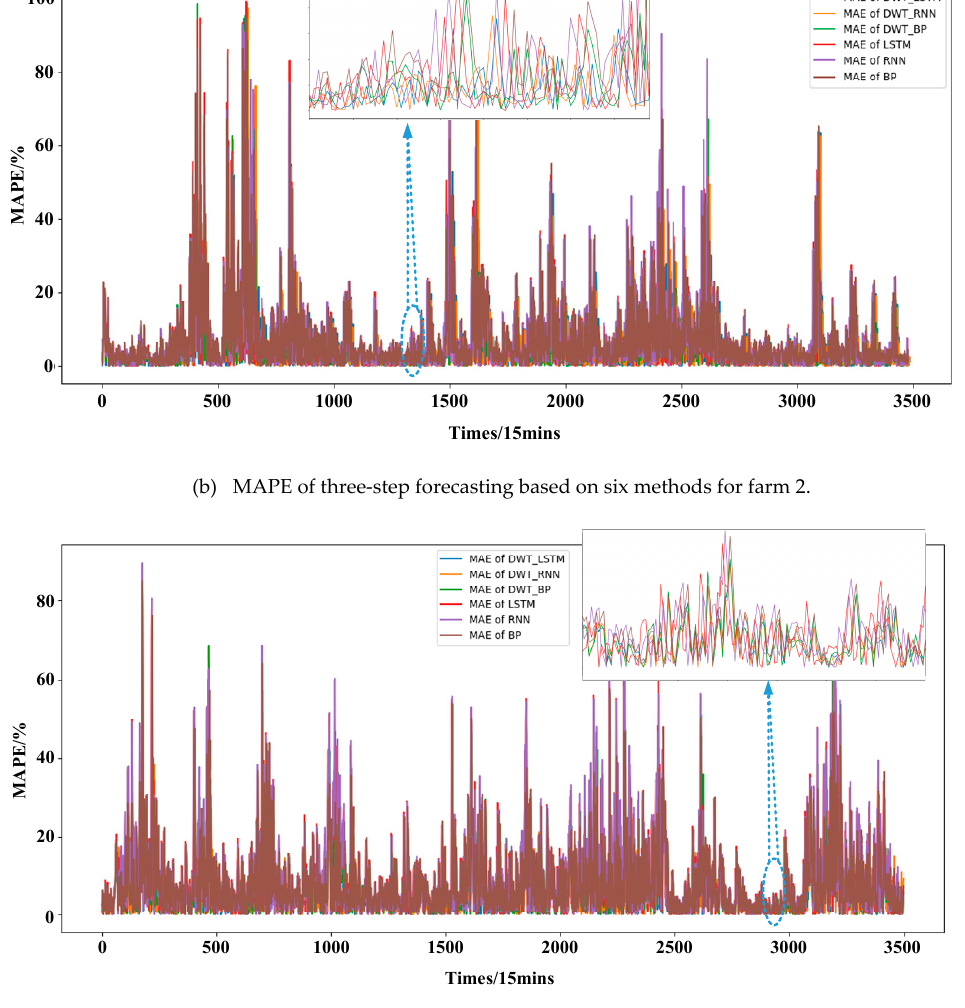
(c) MAPE of five-step forecasting based on six methods for farm 3. Figure 8. Mean absolute percentage error (MAPE) of wind power